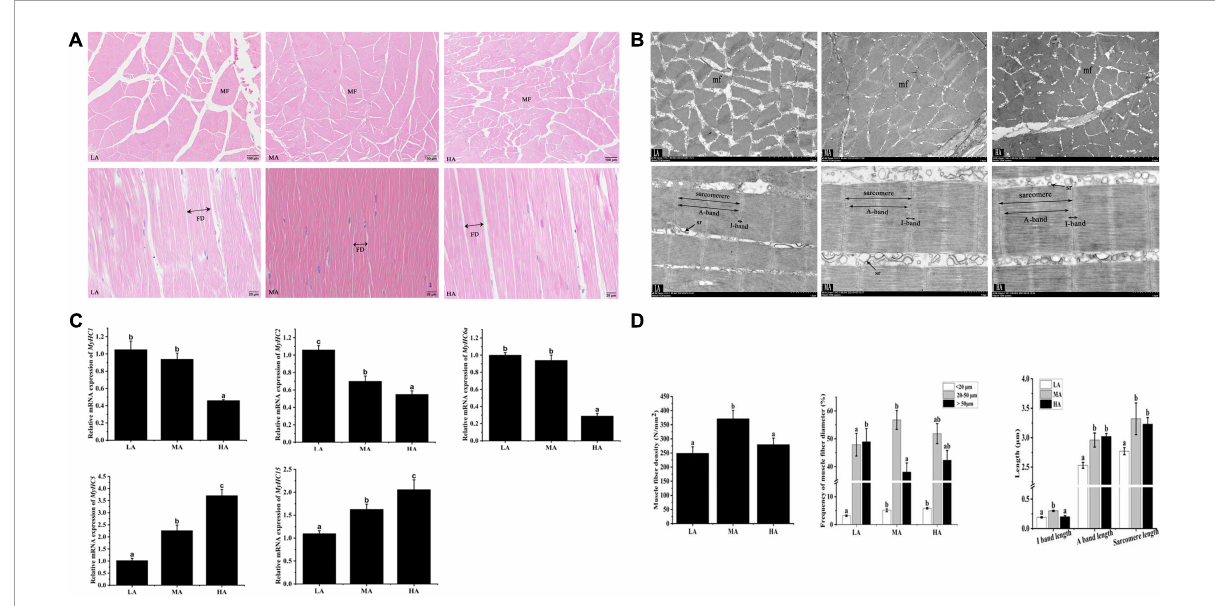
FIGURE1 The morphology of myofiber of Litopenaeus vannamei after dietary arginine treatment for 56 days. (A) Myofiber microstructure of cross-section (Magnification 100 × ) and longitudinal section (Magnification 400 × ). (B) Transmission electron microscope of cross-section and longitudinal section at a magnification of 3,000 × and 8,000 × , respectively. (C) The density and the lengths of diameter, I band, A band, and sarcomere in myofiber of L. vannamei . (D) The relative mRNA expression of MyHCs in L. vannamei . MF, myofiber. mf, myofibril. FD, myofiber diameter. sr, sarcoplasmic reticulum. sMyHC1, sMyHC2, and sMyHC6a are mainly expressed in fast myofibers. sMyHC5 and sMyHC15 are mainly expressed in slow myofibers. LA, the arginine-deficient diet; MA, the arginine-optimal diet; HA, the arginine-excessive